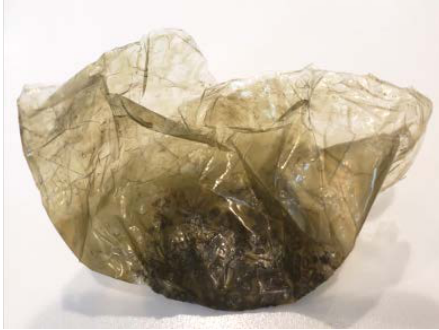
Figure 2. A sample of PHA film produced directly after the solvent recovery. The dark green color was common to all of the samples produced.